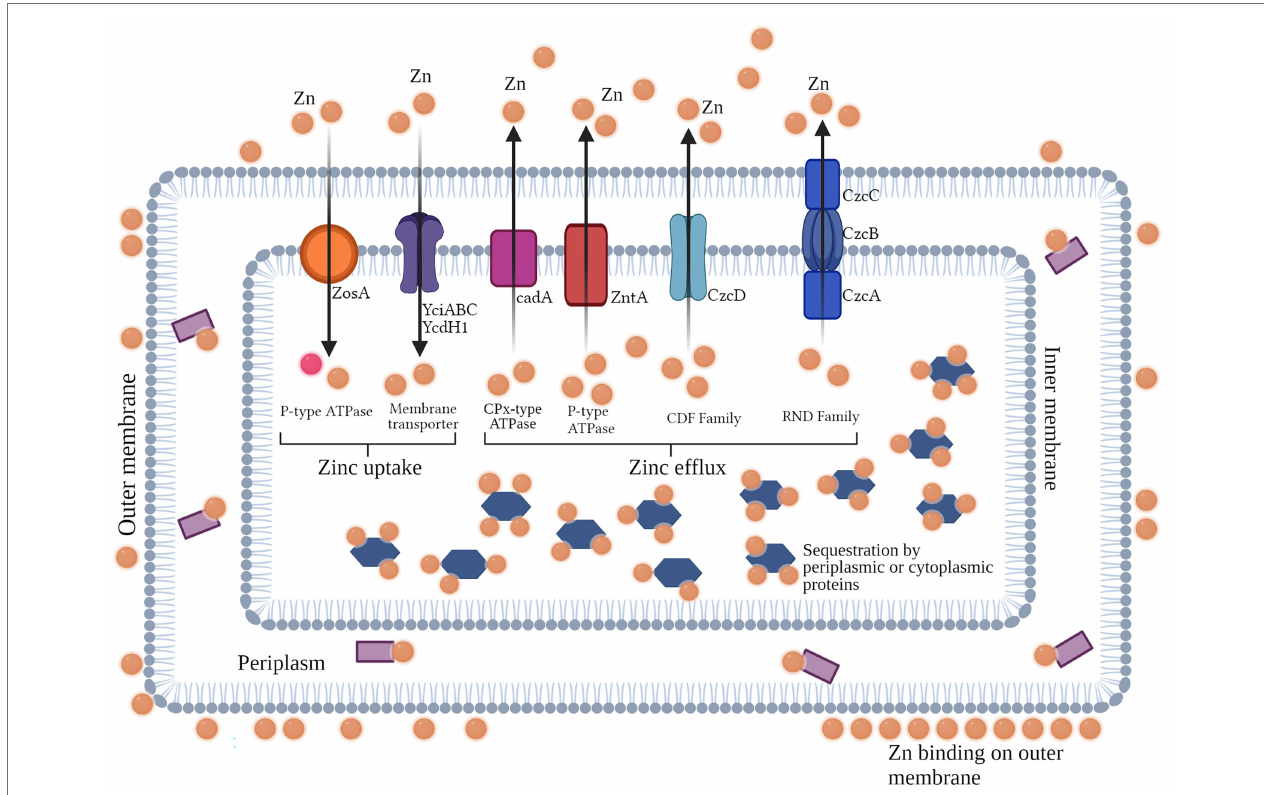
FIGURE 2 | Overview of the general resistance mechanisms for Zn found in Gram-negative and -positive bacteria (Created with BioRender). In Gram negative and positive bacteria, general resistance mechanisms aid in efflux, sequestration, chelation, and metal uptake for their survival in toxic or scarce conditions. For the metal Zn, uptake in Gram positive bacteria from the outer environment is facilitated by P-type ATPase (ZosA), and Zn membrane transporters. For efflux of Zn ions out of the cell, CDF and RND efflux pumps (Czc determinants found in both Gram positive and negative bacteria), as well as CPx-type (CadA in Gram positive bacteria) and P-type ATPases (ZntA in both Gram positive and negative bacteria) are majorly involved. Moreover, intracellular or periplasmic proteins can bind to Zn inside the cell.